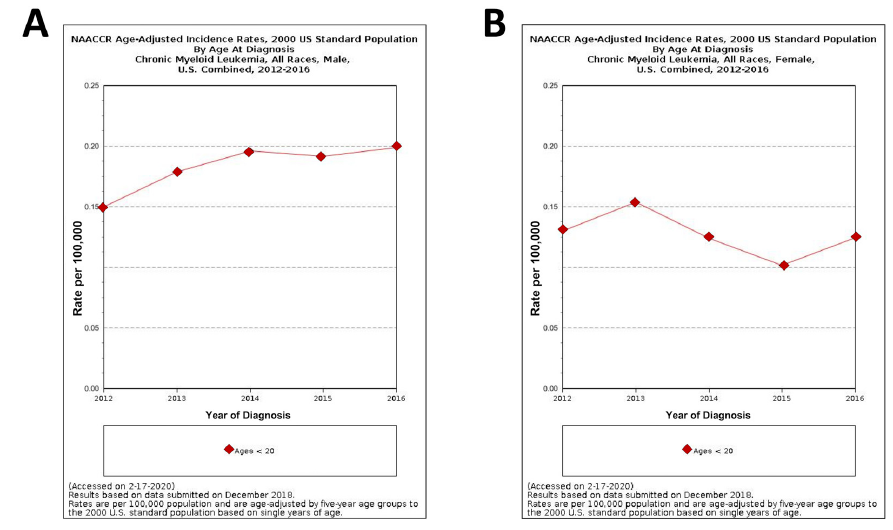
Figure 4. North American Association of central cancer registries (NAACCR) Fast Stats: age-adjusted incidence rates of CML in male and female patients under 20 years of ages ( A ) and ( B ), respectively